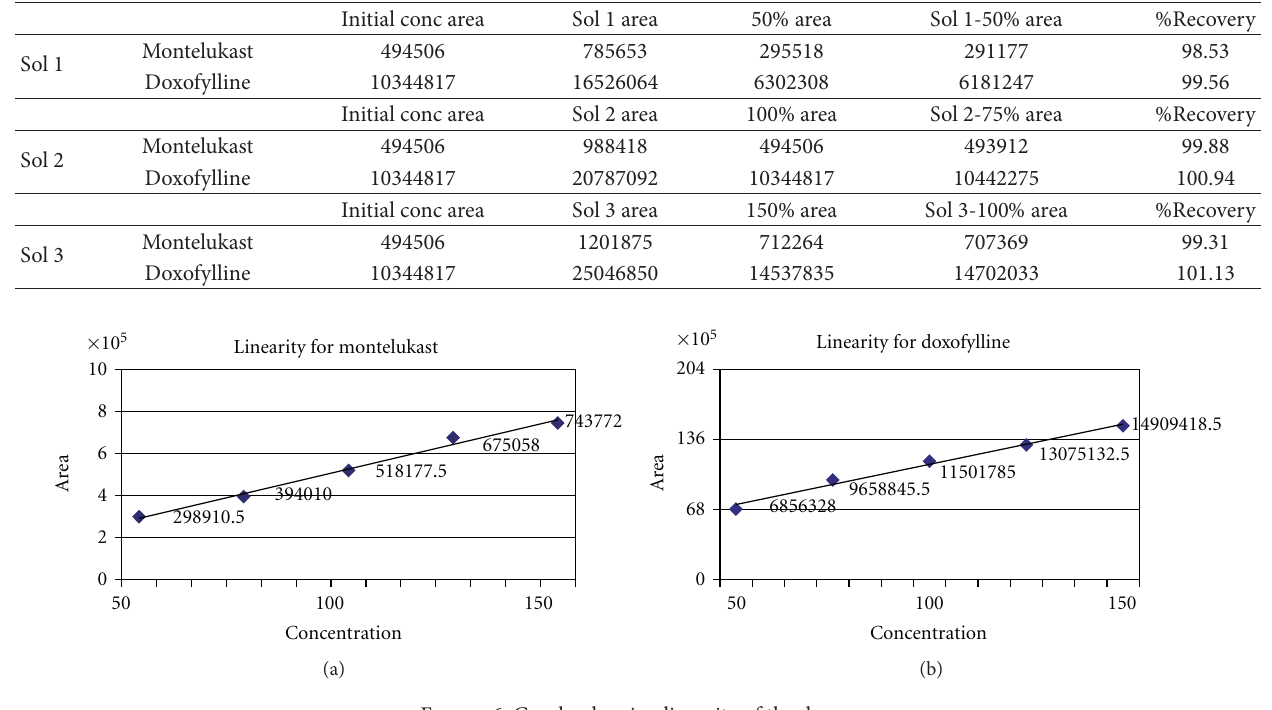
T 3: Results for the accuracy of the method.